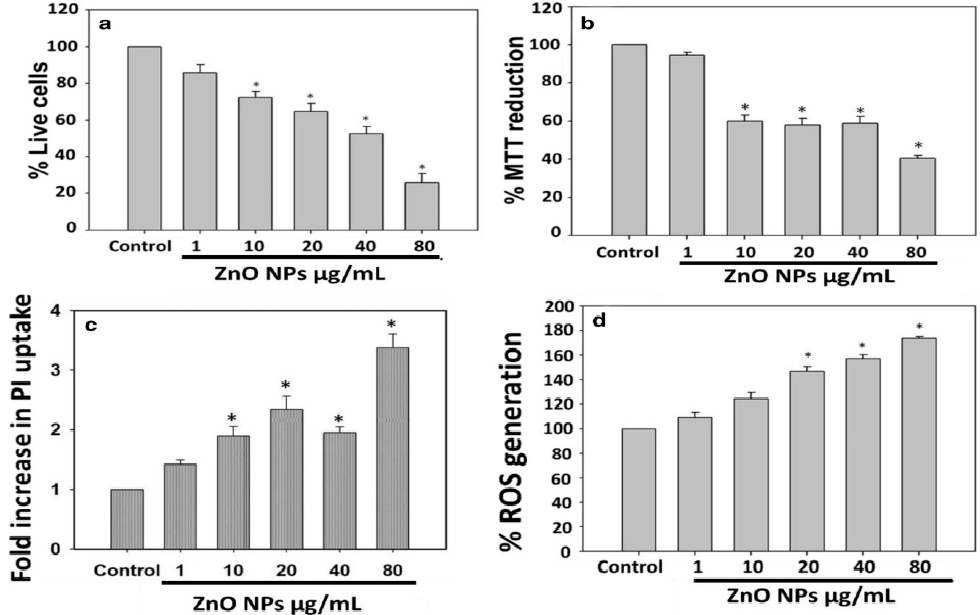
Figure 24. Reduction in viability of D. radiodurans upon exposure to ZnO NPs for 3 h as determined by: ( a ) Colony count method, ( b ) 3-(4,5-dimethylthiazol-2-yl)-2,5-diphenyltetrazolium bromide (MTT) assay, ( c ) propidium iodide (PI) uptake assay, and ( d ) ROS assay. The error bars are the standard deviation ( n = 3); * denotes p < 0.05. Reproduced from [276] under a Creative Commons Attribution 4.0 International License.